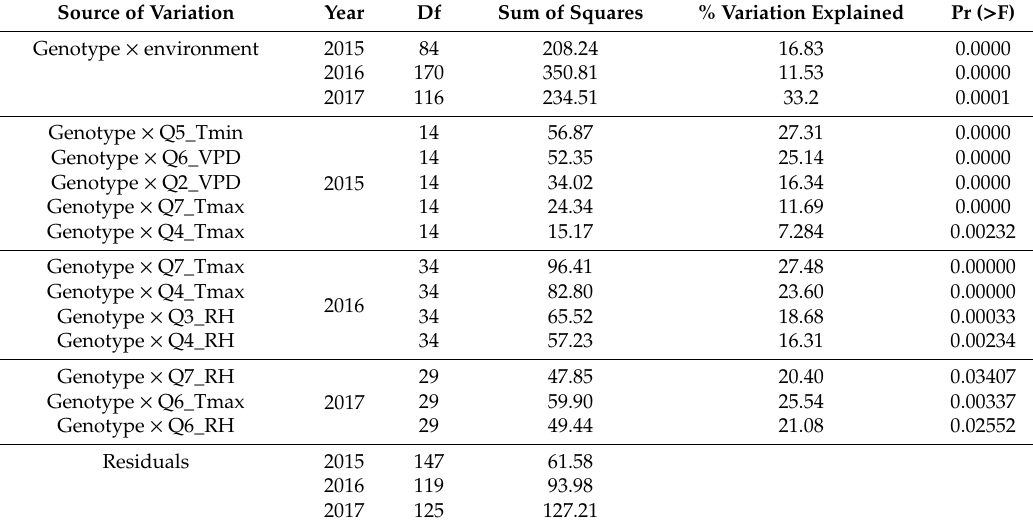
Table 4. Sums of squares and percent variation estimates using environmental covariates to partition genotype × environment interaction variance for grain yield into genotype × environmental covariate interactions, using factorial